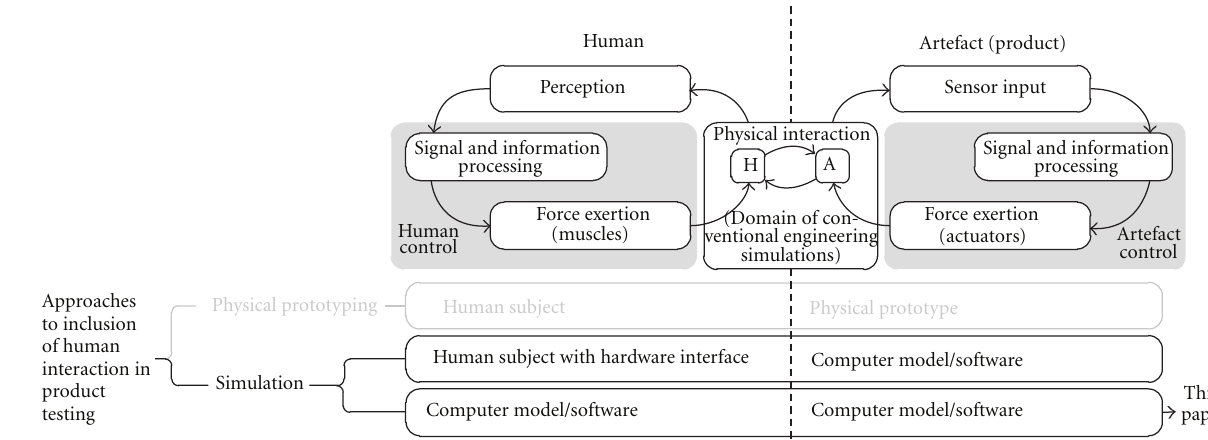
Figure 1: Basic reasoning model of human-artefact interaction (top), with di ff erent approaches to inclusion of human interaction in product testing—in particular, product